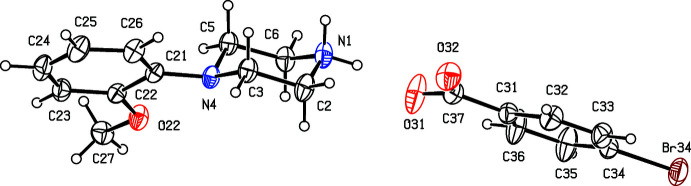
The independent components of compound (II) showing the atom-labelling scheme. Displacement ellipsoids are drawn at the 30% probability level.